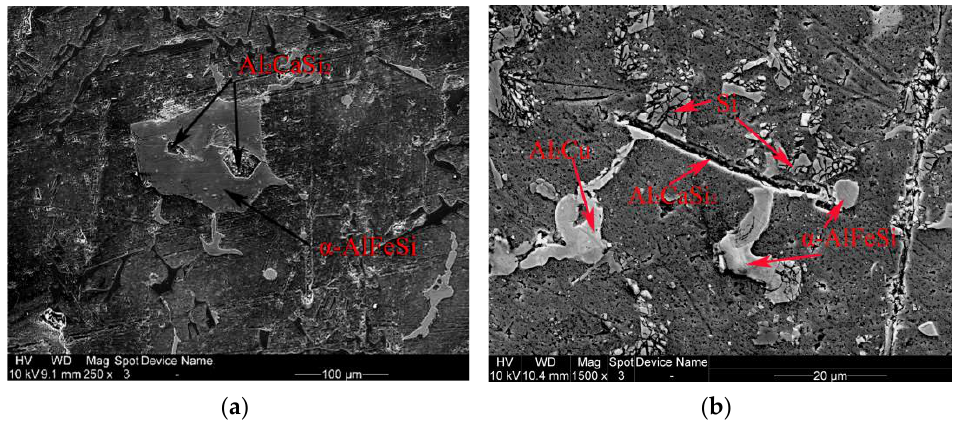
Figure 5. Relations of Al 2 CaSi 2 and α -AlFeSi: ( a ) SEM images showing nucleation of α -AlFeSi from polygon-shaped Al 2 CaSi 2, retrieved from [21]; ( b ) SEM images showing nucleation of α -AlFeSi from needle-shaped Al 2 CaSi 2 .